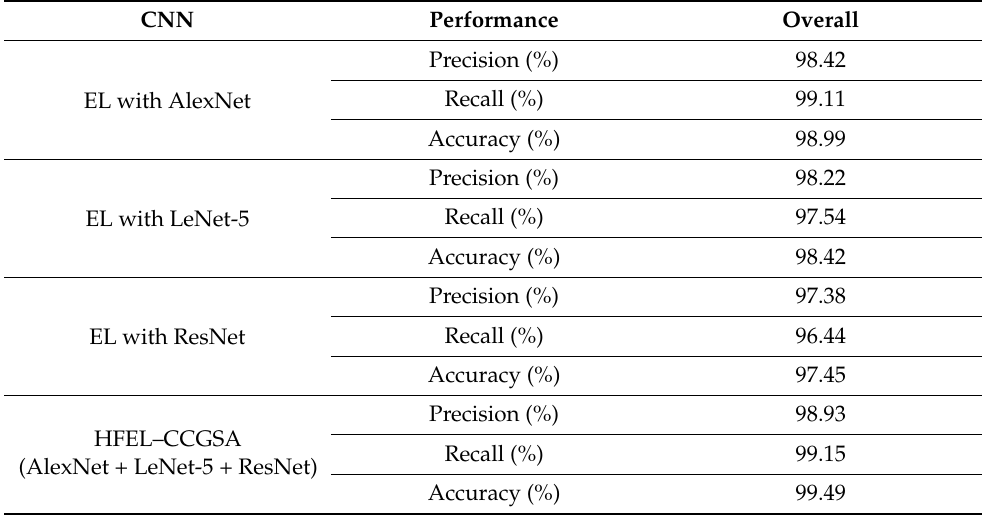
Table 8. Performance analysis for individual CNNs and HFEL–CCGSA (AlexNet + LeNet-5 + ResNet) on Eurosat dataset.